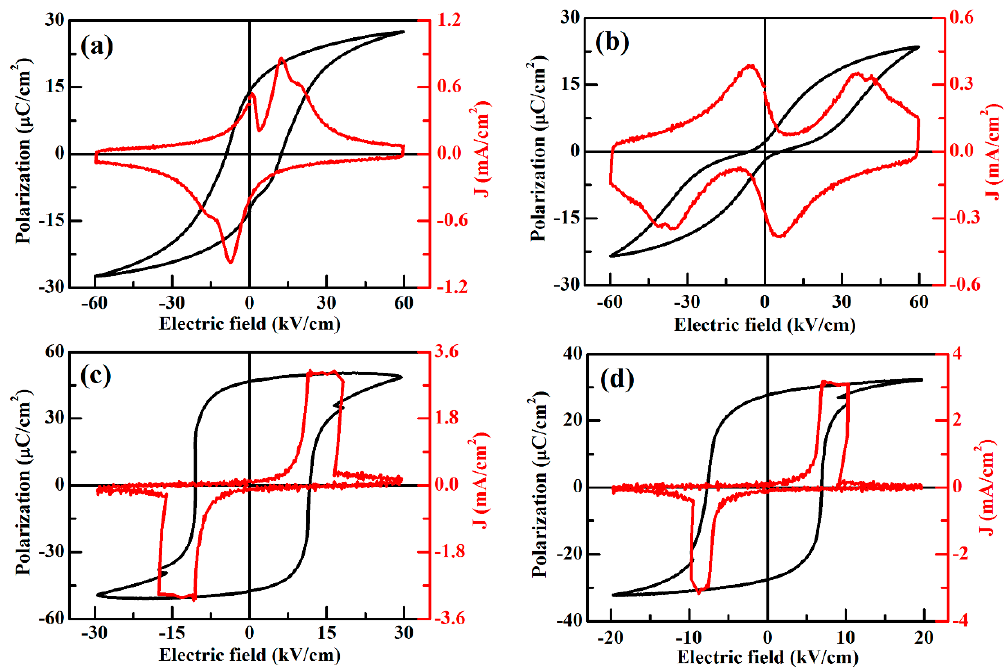
Figure 3. The polarization–electric field ( P – E ) hysteresis loops and the current density–electric field ( J – E ) curves measured 1 Hz for PZT ceramics: ( a ) P4, ( b ) P8, ( c ) P5, and ( d ) P5H.